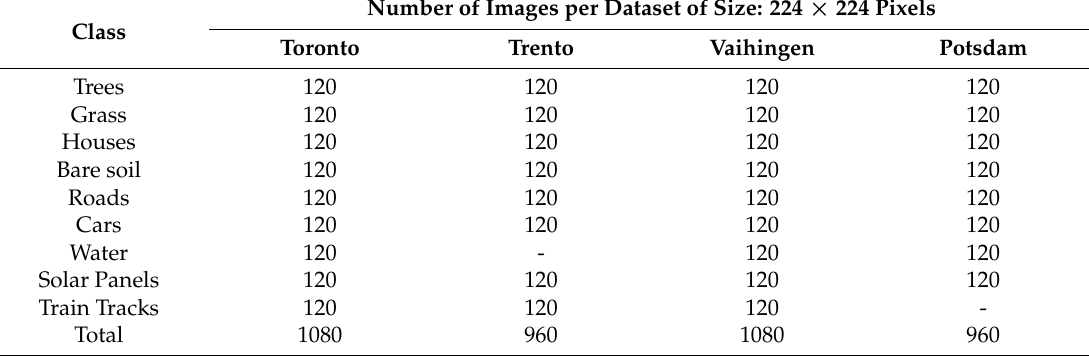
Table 1. Cross-domain scenarios built from Toronto, Trento, Vaihingen, and Potsdam